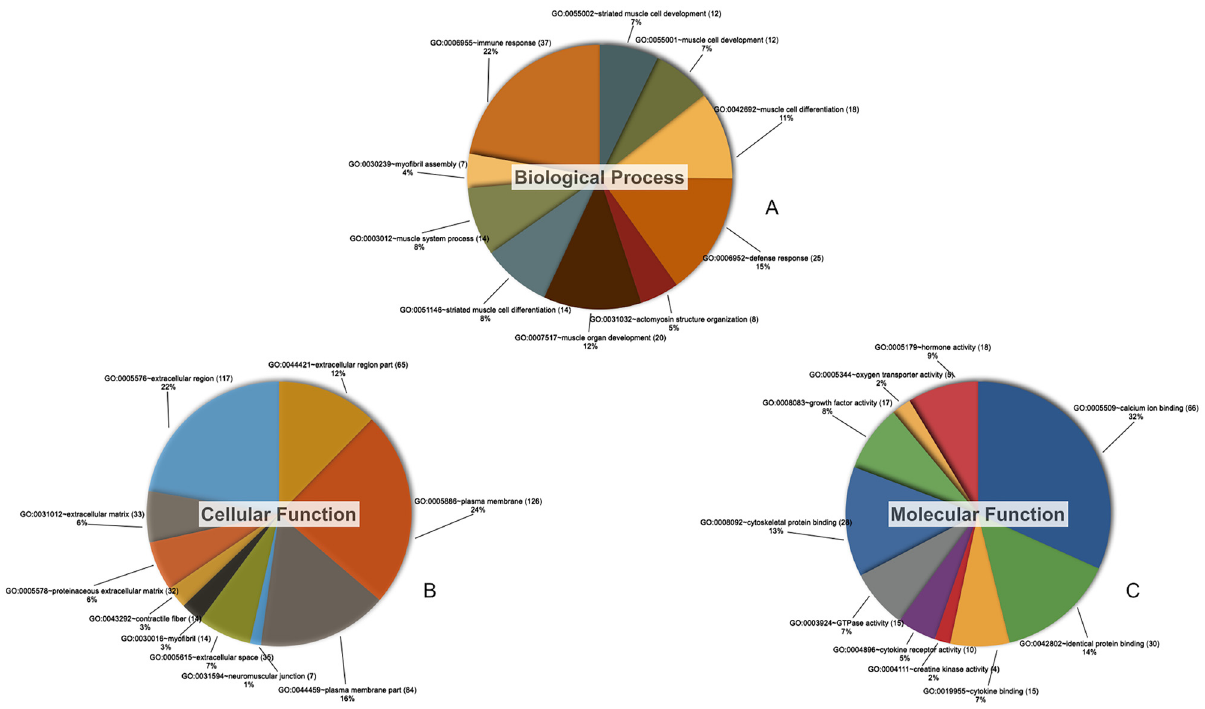
Fig 4. Gene ontology analysis of differentially expressed genes according to their biological process (A), cellular function (B), and molecular function (C). Each colour represents a different GO term, and the number of enriched target genes are shown after the name of the GO term. Only the top ten GO terms in each category are listed here. The complete GO analysis dataset is shown in S3